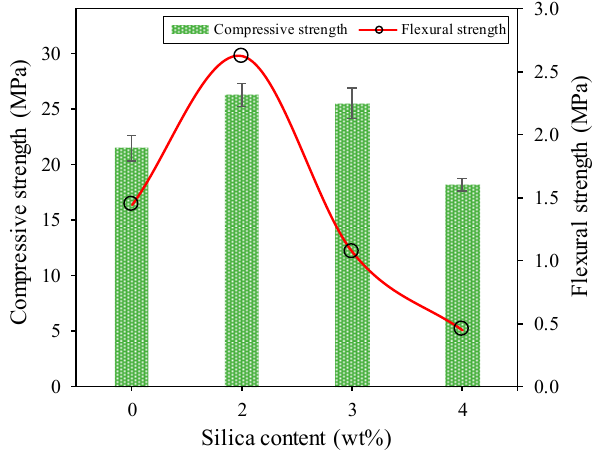
Figure 7. Compressive strength and flexural strength of geopolymer with some silica content.